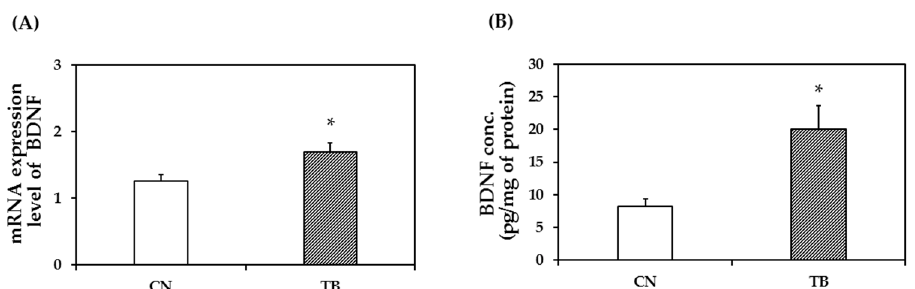
Figure 8. The e ff ect of theobromine (TB) on brain derived neurotrophic factor (BDNF) mRNA and protein levels. ( A ) Relative mRNA expression and ( B ) protein level in TB-fed rat (TB rats) of BDNF were significantly higher than those of control rats (CN rats) in the prefrontal cortex. Hippocampal BDNF protein levels did not di ff er between groups (Figure S2). Values are the mean ± S.E.M. ( n = 6 for each group). * p < 0.05; significant di ff erence between groups.